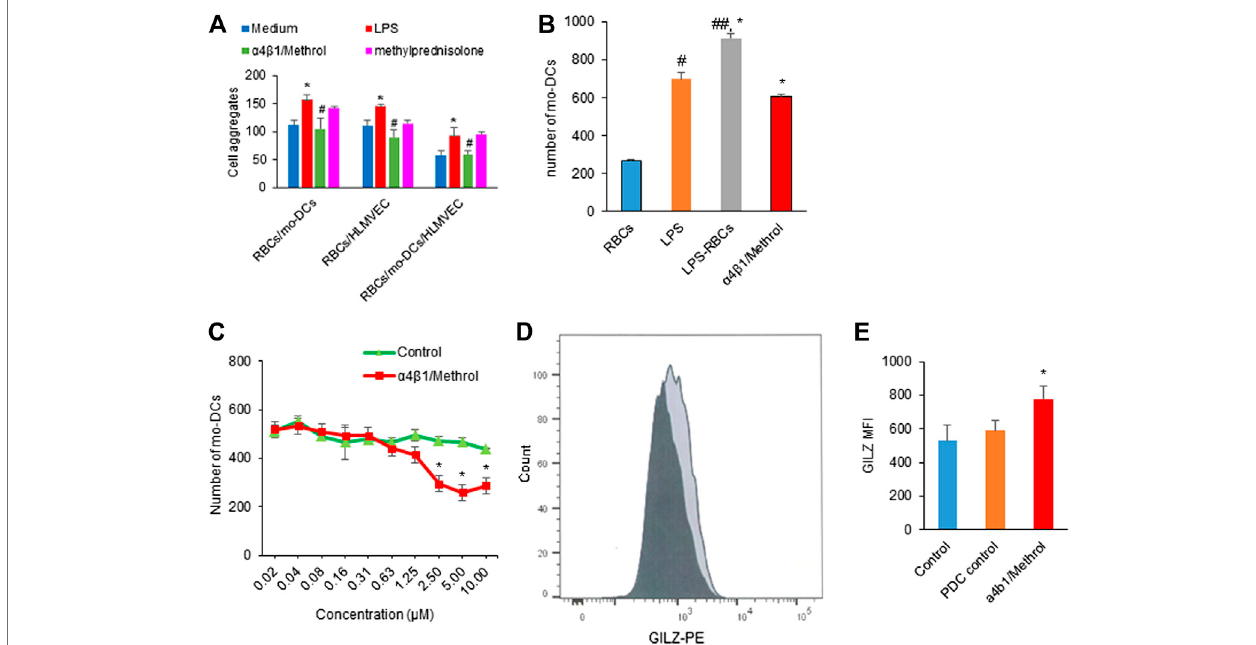
FIGURE 5 | (A) LPS pretreated RBCs induced cell-cell aggregation on RBCs/mo-DCs, RBCs/HLMVEC, and RBCs/mo-DCS/HLMVEC (* p < 0.05 vs. untreated groups). Such effects were blocked by α 4 β 1/Methrol (# p < 0.05). (B) LPS or L-sup enhanced mo-DCs migration (* p < 0.05, ## p < 0.01 vs. C-sup; * p < 0.05, L-sup vs. LPS alone) which was attenuated by α 4 β 1/Methrol (* p < 0.01 vs. L-sup). (C) α 4 β 1/Methrol decreased L-sup induced mo-DCs migration in a concentration-dependent manner[* p < 0.05 vs. peptide drugconjugate (PDCcontrol)].Datawererepresentative ofmean ± SDofthreeexperiments. (D) GILZ-expressingmo-DCs analyzed by fl ow cytometry (dark color: PDC control; light black color: 10 µM α 1 β 4/Methrol treatment for 24 h). (E) MFI values of GILZ-expressing mo-DCs quantitated by fl ow cytometry. α 4 β 1/Methrol signi fi cantly increased the number of mo-DCs expressing GILZ as compared to PDC control (* p <